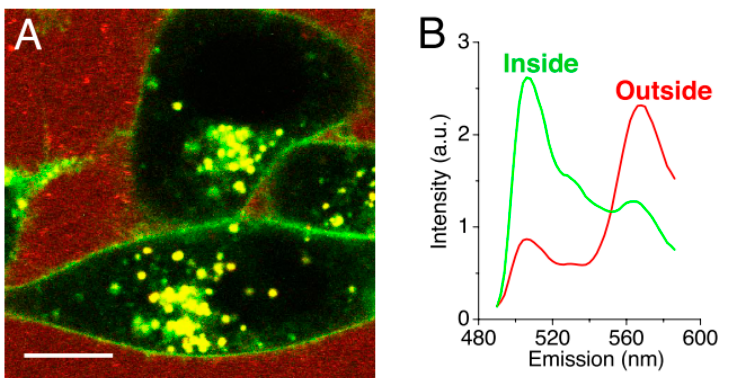
Figure 6. ( A ) Confocal fluorescence image of KB cells incubated with DiO / DiI loaded micelles. The image shows the loss of Förster resonance energy transfer on the cell surface and intracellular space. ( B ) Normalized spectra of the measured fluorescent signal outside (red) and inside (green) the cells. (Scale bar: 10 µ m.) (Adapted from Reference [49], Copyright 2008 National Academy of Sciences).